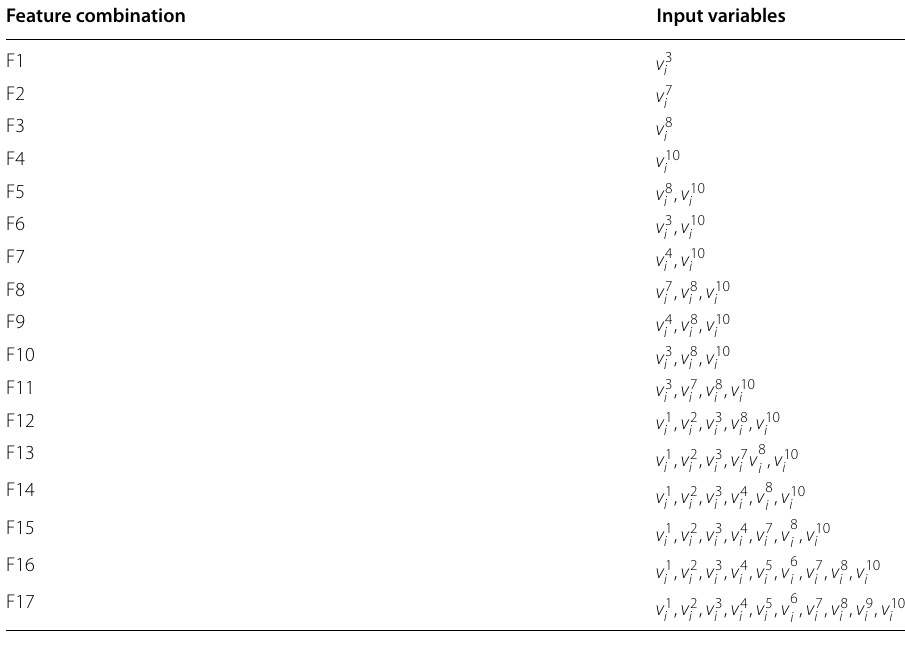
Table 2 The input variables associated with each feature combination Feature combination